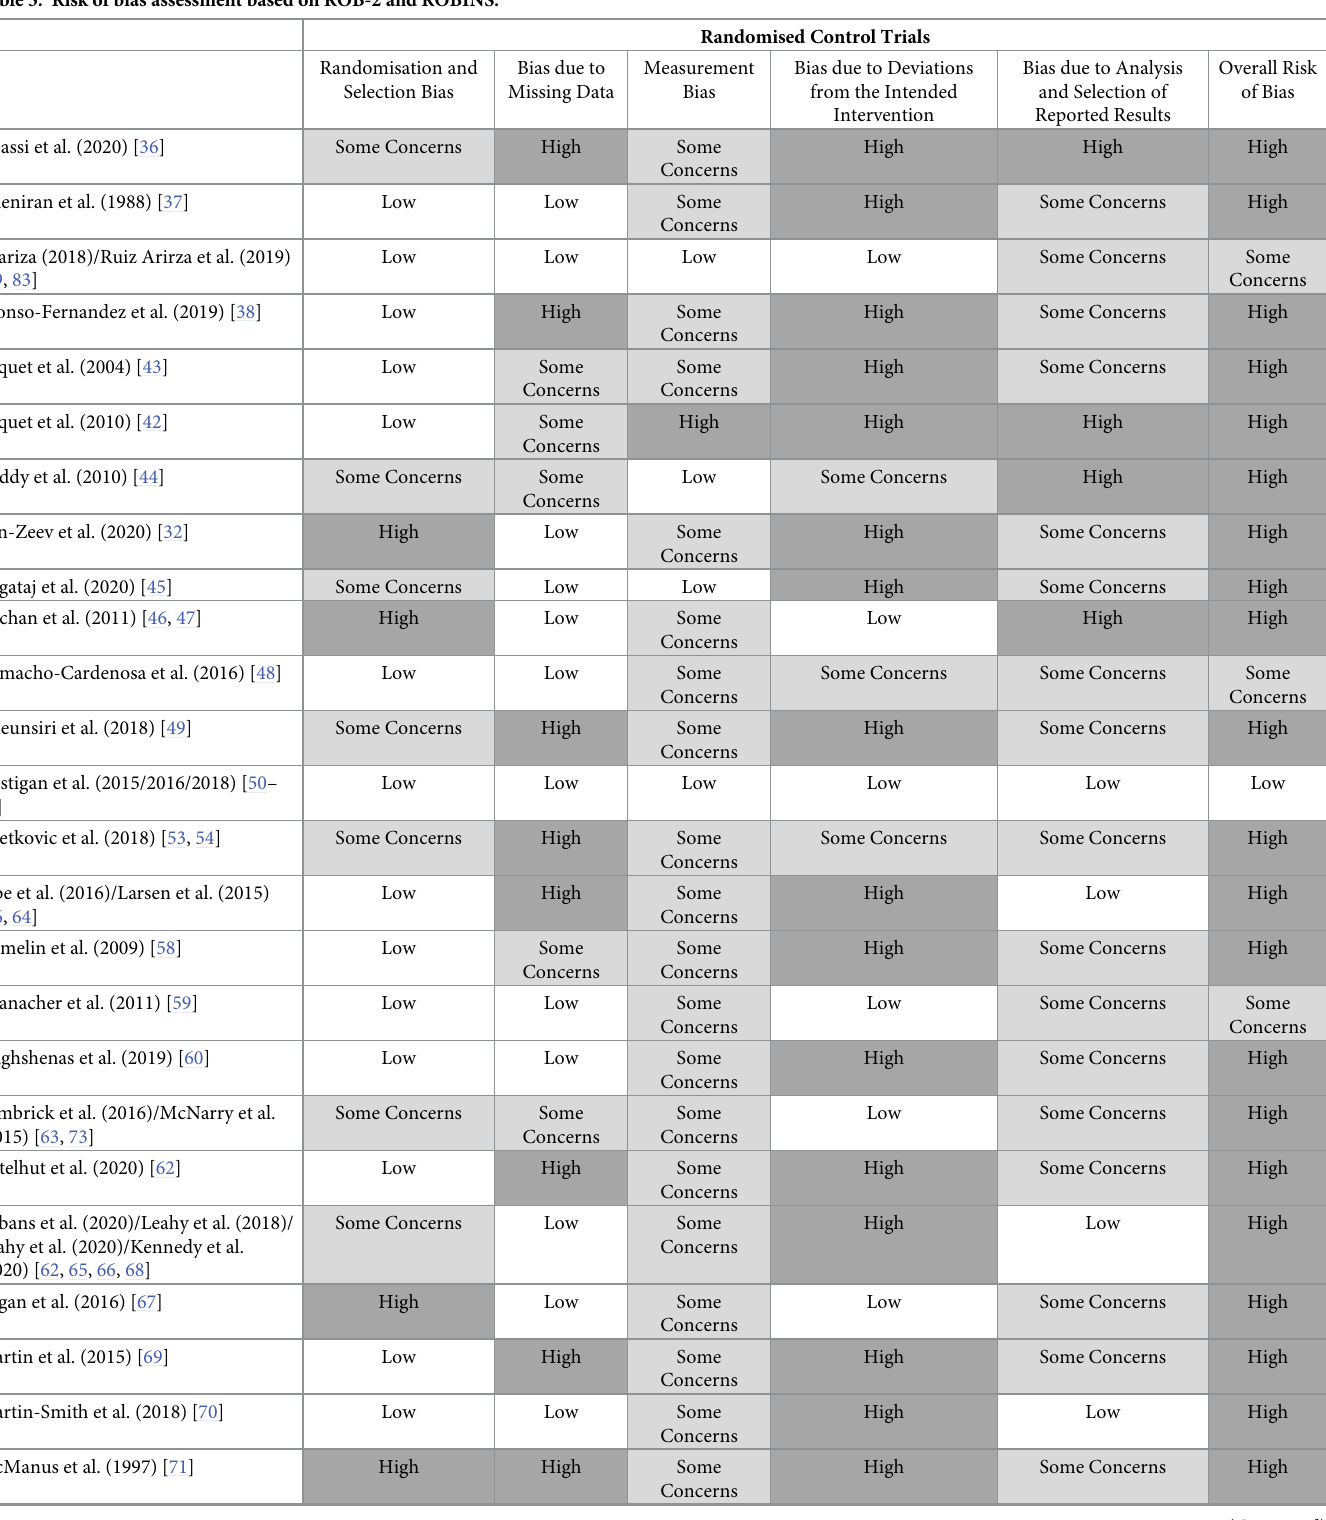
Table 3. Risk of bias assessment based on ROB-2 and